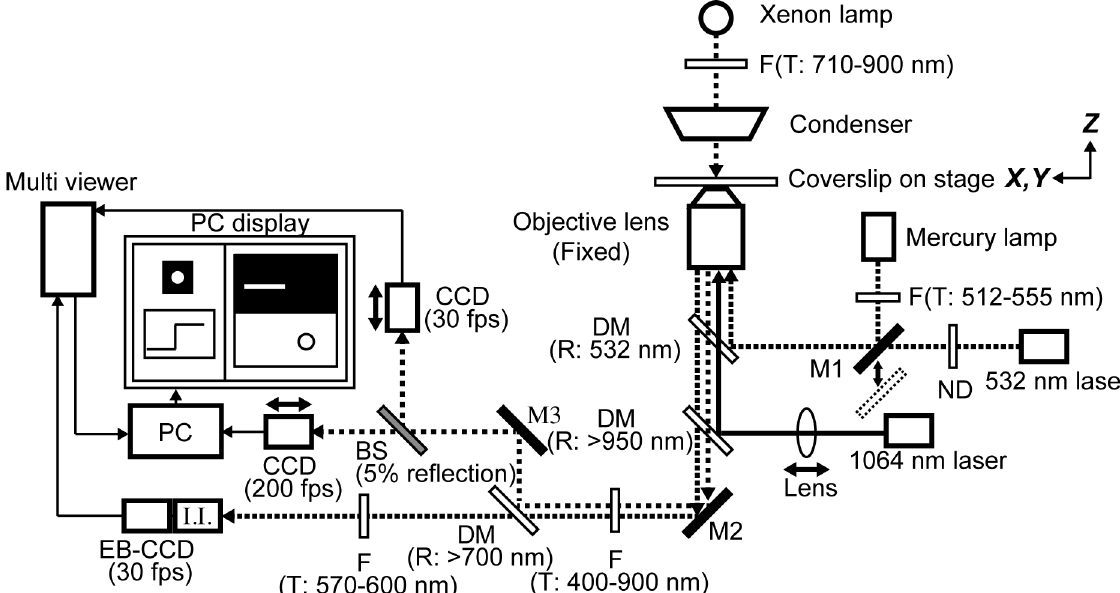
Fig 2. Schematic diagram of the optical setup. The optical setup for optical tweezers, bright-field microscopy and fluorescence microscopy were built on an inverted microscope. The position of the objective lens was fixed, whereas X , Y and Z positions of the sample stage were adjustable (indicated by arrows). The focal plane of 1064 nm laser for optical tweezers can be adjusted by shifting the position of a lens (’Lens’ with a double-headed arrow placed in the light path of 1064 nm laser) along the light path. A xenon lamp was used as the light source at 710– 900 nm to obtain bright-field images of beads. The bright-field images split by a beam sampler (BS) were projected onto two individual CCD cameras. One CCD camera worked at 200 fps, and its images were captured by a PC and analyzed in real time to track the position of the bead. The other CCD camera (30 fps) was connected to a multi viewer. The focal planes of these two CCD cameras were adjusted individually by the position of the camera along the light path (indicated by double-headed arrows). For fluorescence imaging, 532 nm laser and mercury lamp were used as light sources for total internal reflection microscopy and epifluorescence microscopy, respectively. These two fluorescence imaging methods could be alternated by shifting the mirror position (M1, shown with a double-headed arrow). Fluorescence images were captured by an EB-CCD camera (30 fps) serially connected with an image intensifier (I.I.) and transmitted to the multi viewer. Bright-field and fluorescence images combined by the multi viewer were shown side-by-side and captured by a PC for recording and analysis purposes. All images were shown in a PC display during the experiment. F, filter. M, mirror. DM, dichroic mirror. BS, beam sampler. ND, neutral density filter. T, transmitted wavelength. R, reflected